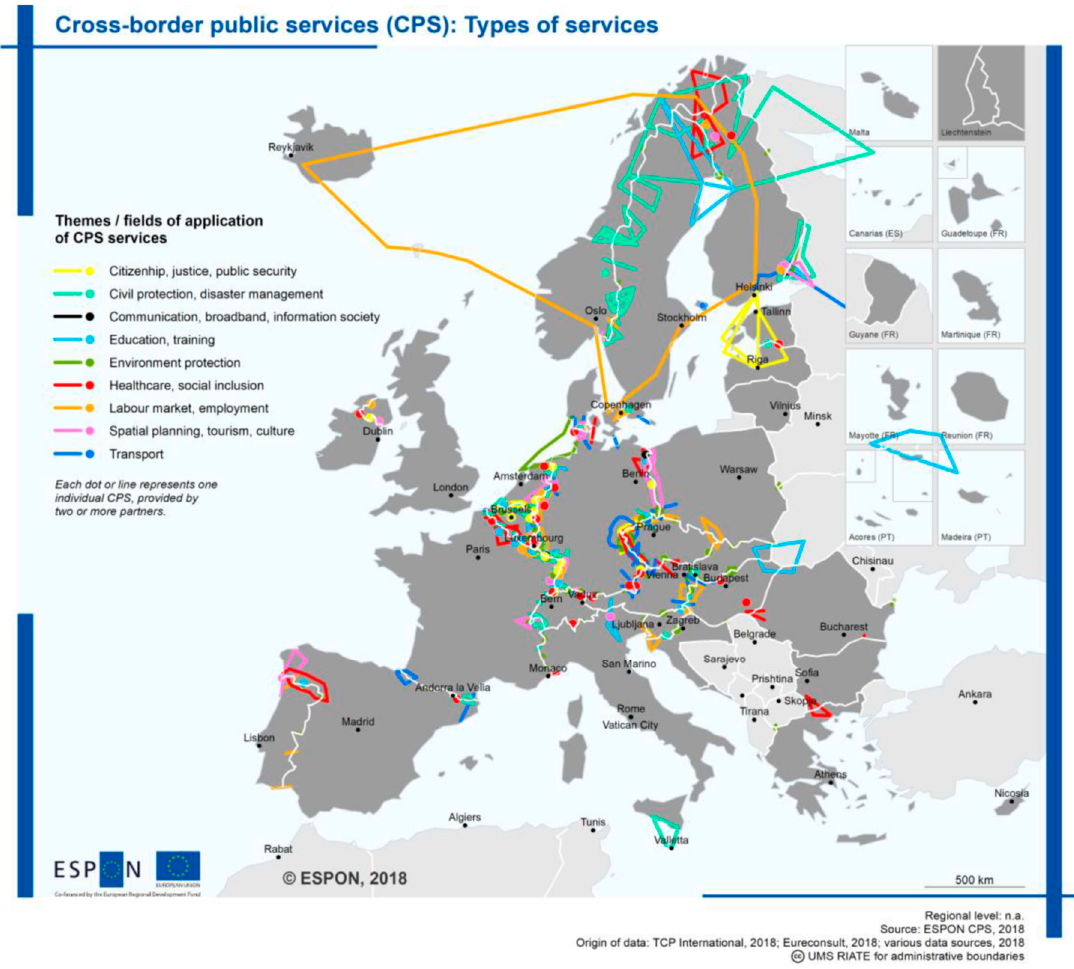
Figure 2. Cross-border public services (CPS): Types of services. Source: ESPON working paper, 2019, p. 8.